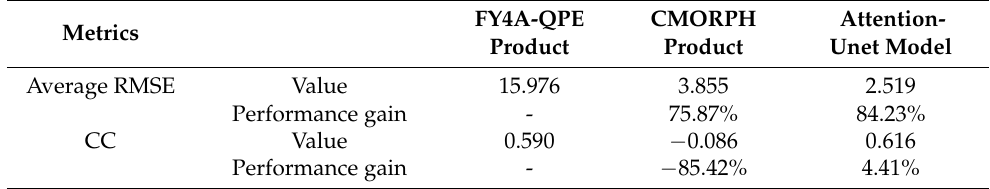
Table 7. Summary of precipitation estimation performance over extreme precipitation